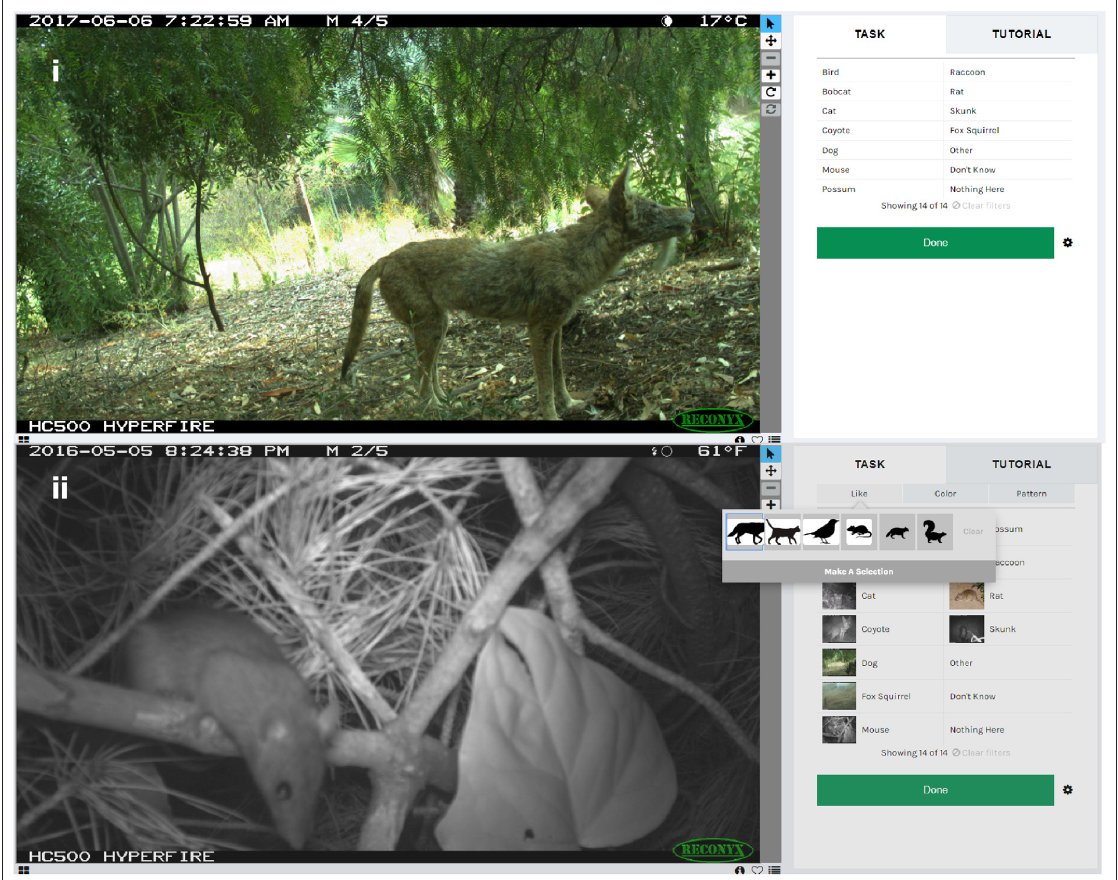
Figure 1: Zooniverse treatments for identifying wildlife images from camera traps. ( i ) The “No JITT” treatment includes the choices available on the right for identifying the animal, but no further assistance is provided. ( ii ) The “JITT” treat- ment includes tutorials to assist the user in identifications. Shown is what the participant would see if they selected the “Like” button, which displays the morphology choices. The “Color” and “Pattern” filters are also available to the participant with the “JITT” treatment, displaying the animals’ possible colors and coat patterns, respectively. In addi- tion to these three categories, each animal choice has a photo associated with it, as well as a short description once that animal is